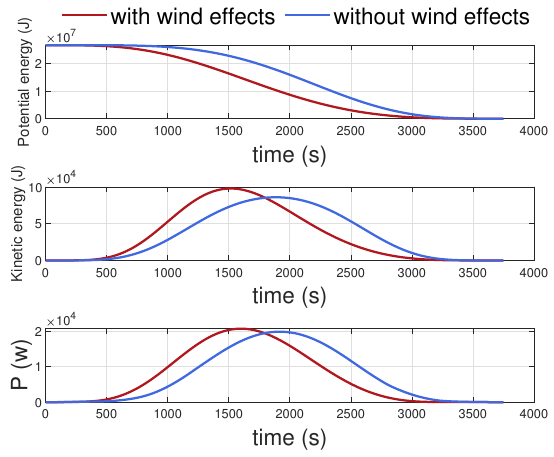
Figure 11. Energy and power changes during the airship’s return